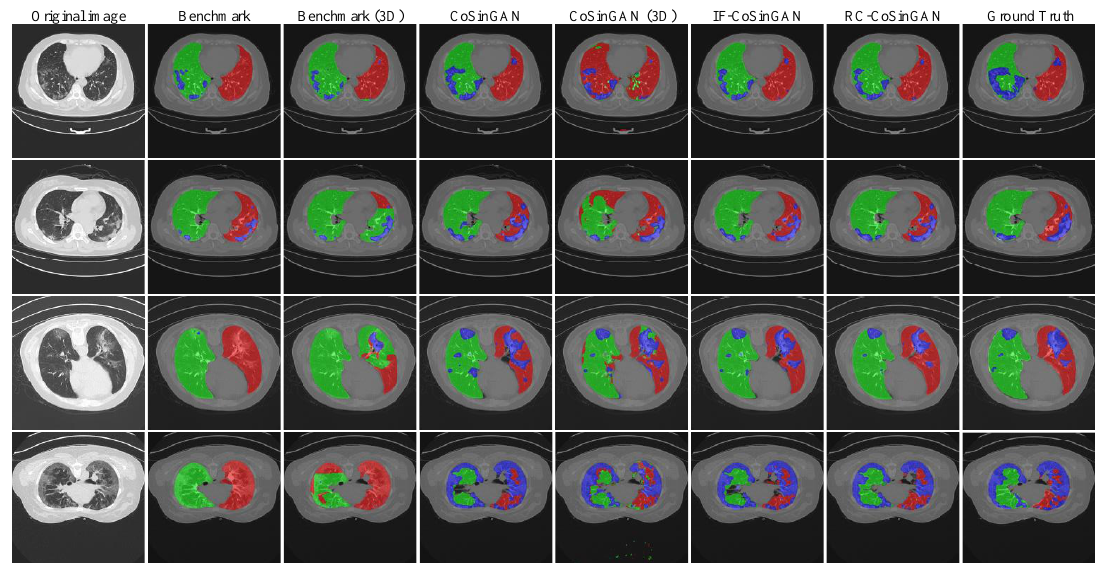
Figure 15. Visual comparison of lung and infection segmentation results on the COVID-19-CT-Seg dataset, where the red, green, and blue represent the left lung, right lung, and infected regions, respectively. Benchmark (3D) and CoSinGAN (3D) represent their results are based on 3D U-Net, whereas the others are all based on 2D U-Net. All results here come from the Fold-4. The blue, green, and red denote the infected regions, right lung and left lung, respectively.